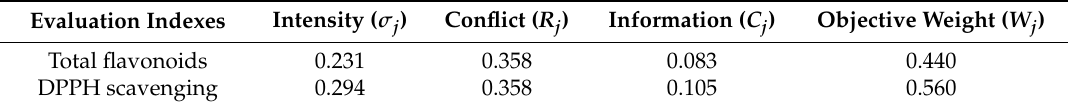
Table 4. Comparison of intensity, conflict, information, and objective weight of evaluation indexes.